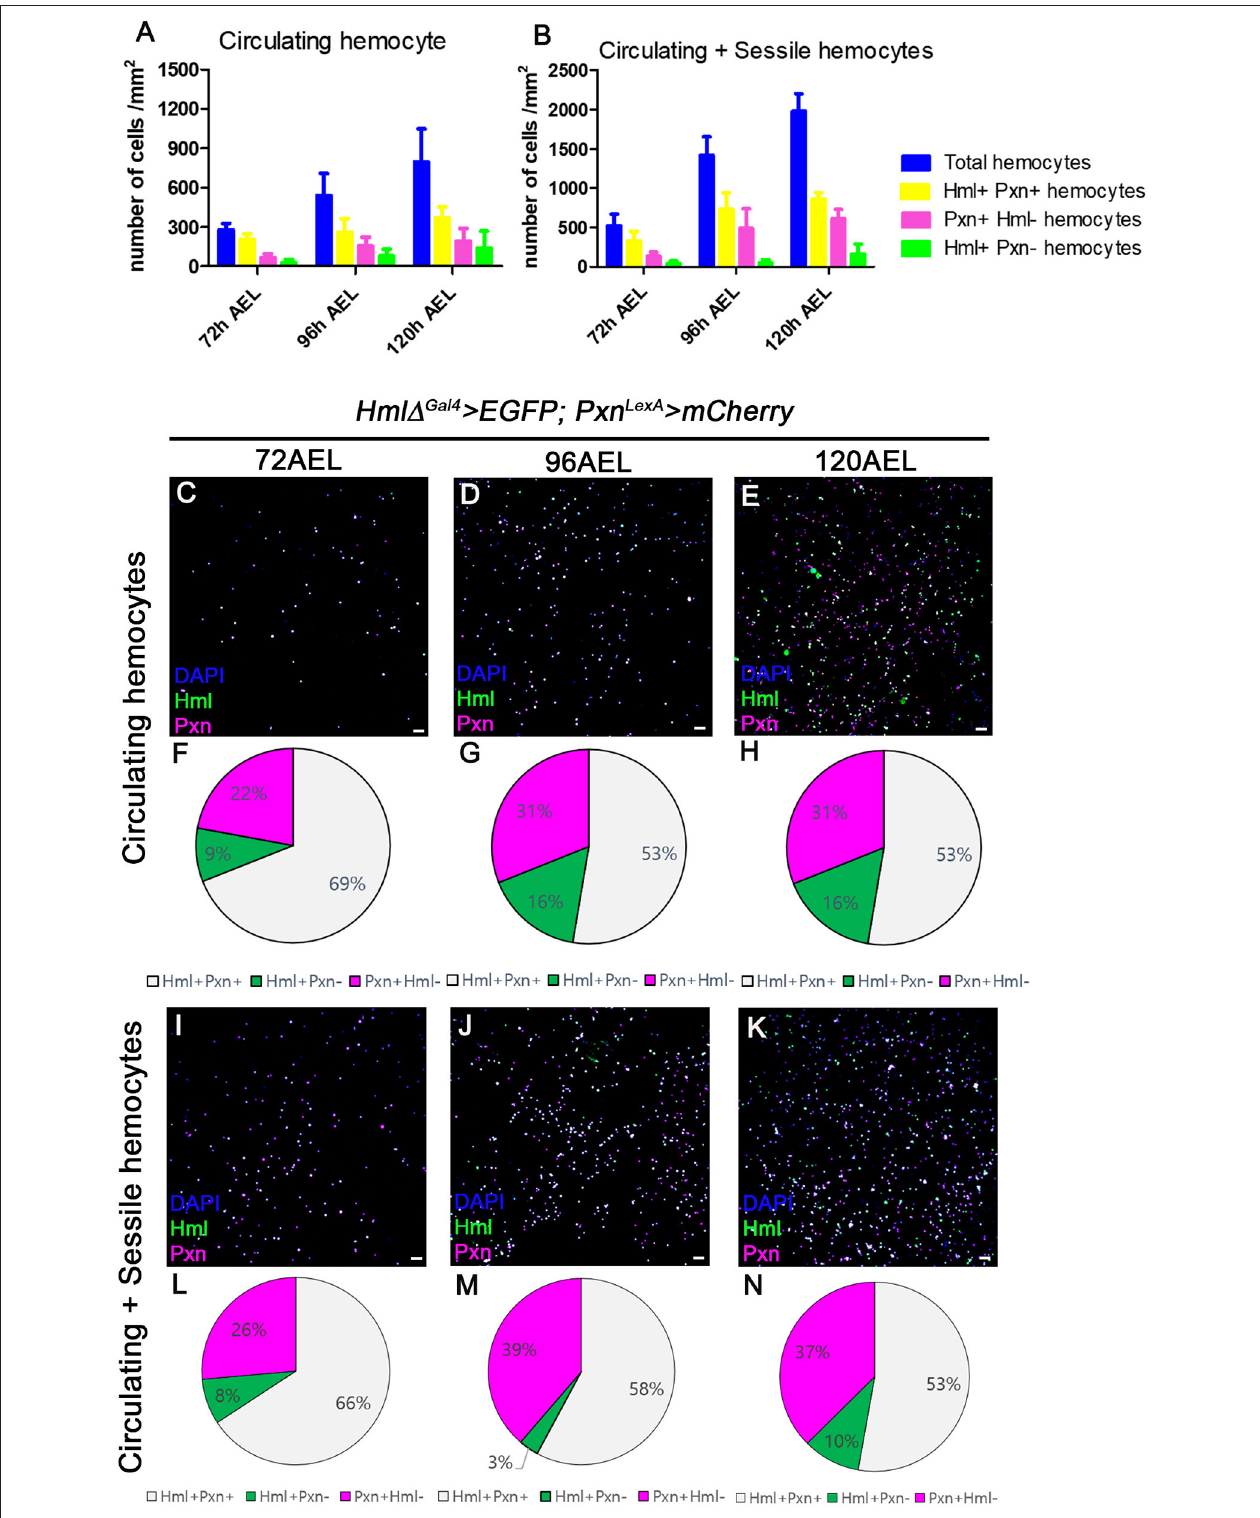
FIGURE 1 | Distribution of total hemocytes during larval development. (A,B) Absolute numbers of hemocytes per mm 2 at 72, 96, and 120h after egg laying (AEL). Total (blue), Hml + Pxn + (yellow), Pxn + Hml − (magenta), and Hml + Pxn − (green) hemocytes are increased over development in circulating (A) and total hemocytes (B)